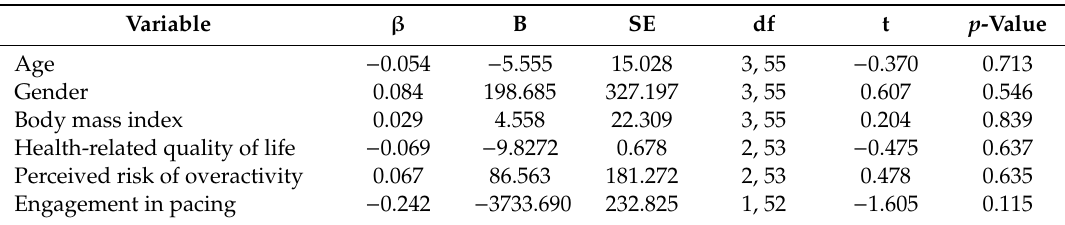
Table 4. Hierarchical linear regression model showing the relationship between engagement in pacing and physical